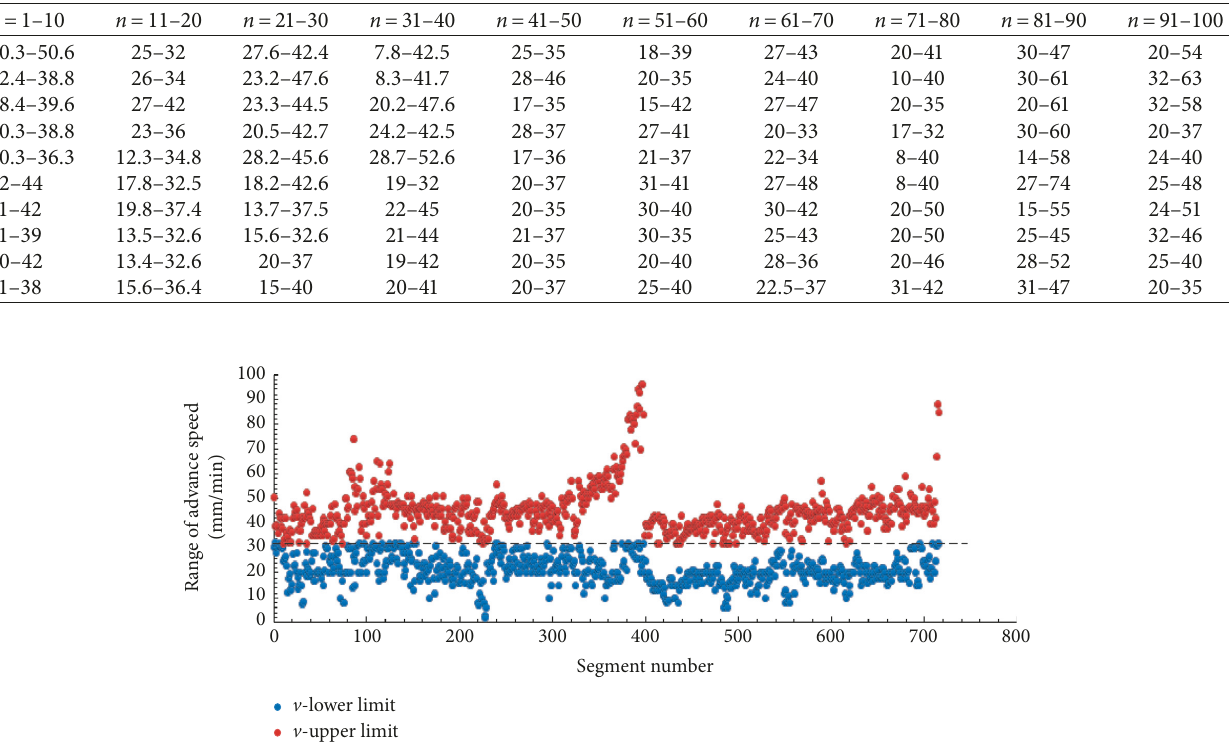
Table 3: Partial construction log of the “normal excavation speed” in the XWS.